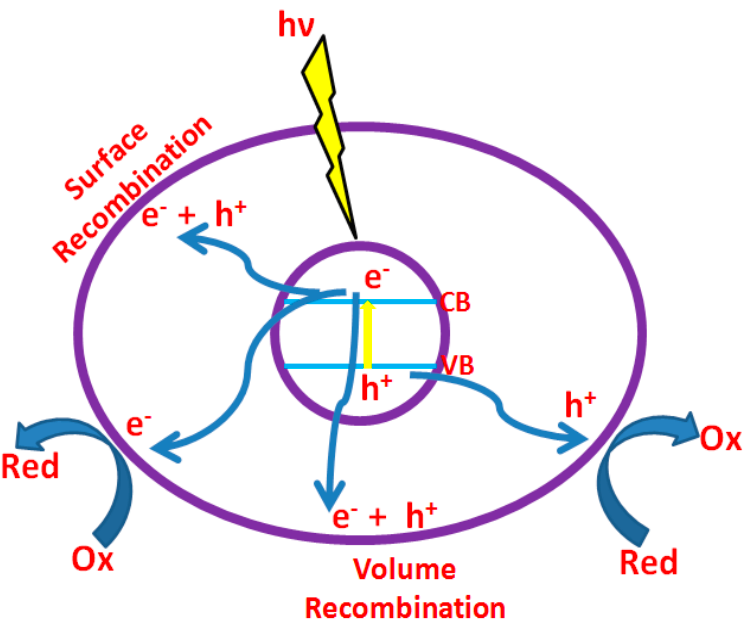
Figure 3. Different processes (reduction, oxidation, surface recombination, etc.) takes place after irradiation of photocatalyst.